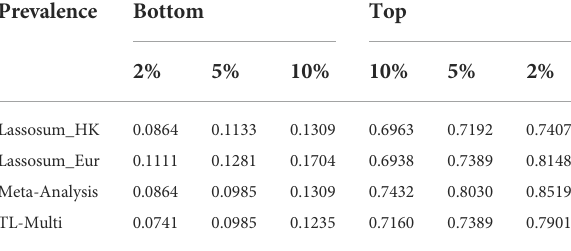
TABLE 1 Case prevalence of 2, 5, and 10% for the top and bottom quantiles of the PRS distribution in the analysis of SLE study with the target Hong Kong population and auxiliary European population, generated by Lassosum, meta-analysis, and TL-Multi.